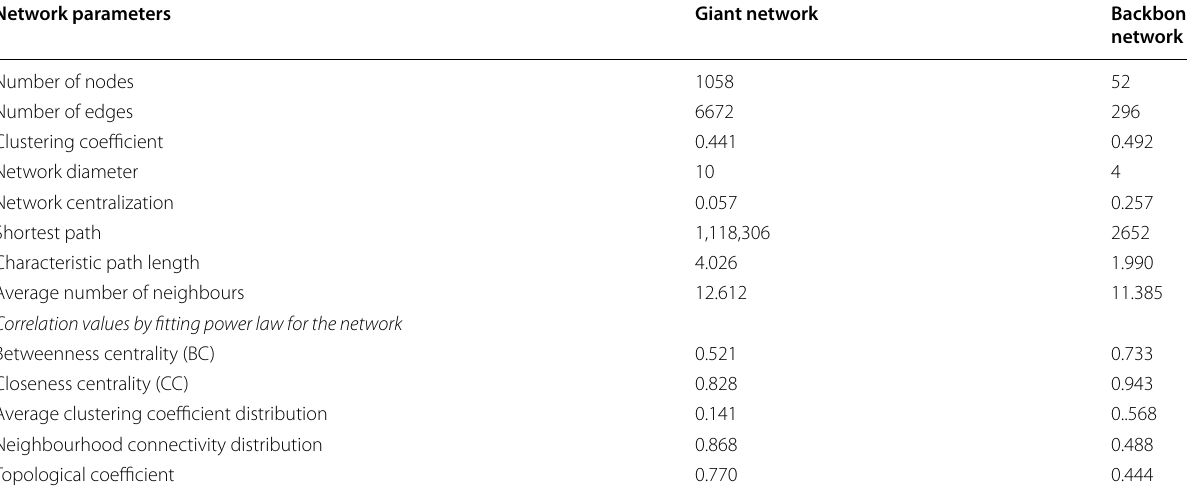
Table 1 General network measurements for giant and backbone networks for the DEGs in T2DM-TB Network